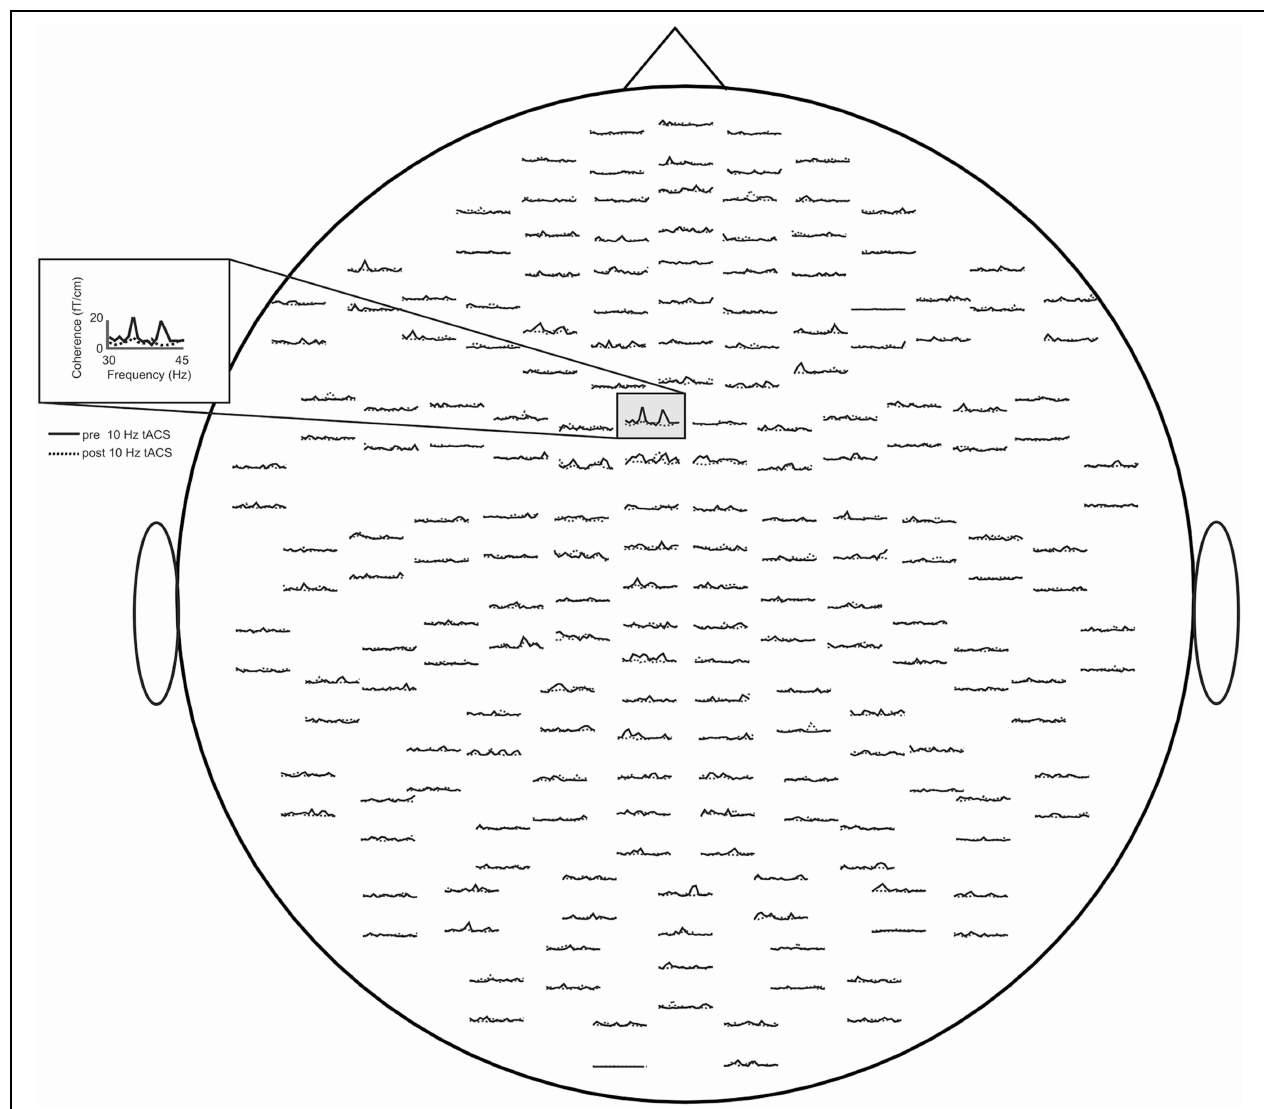
FIGURE 3 | Averaged sensor-plot for CMC within the low gamma band (30–45Hz) prior to and post 10Hz tACS. The insert indicates the sensor with the largest amplitude change following tACS.